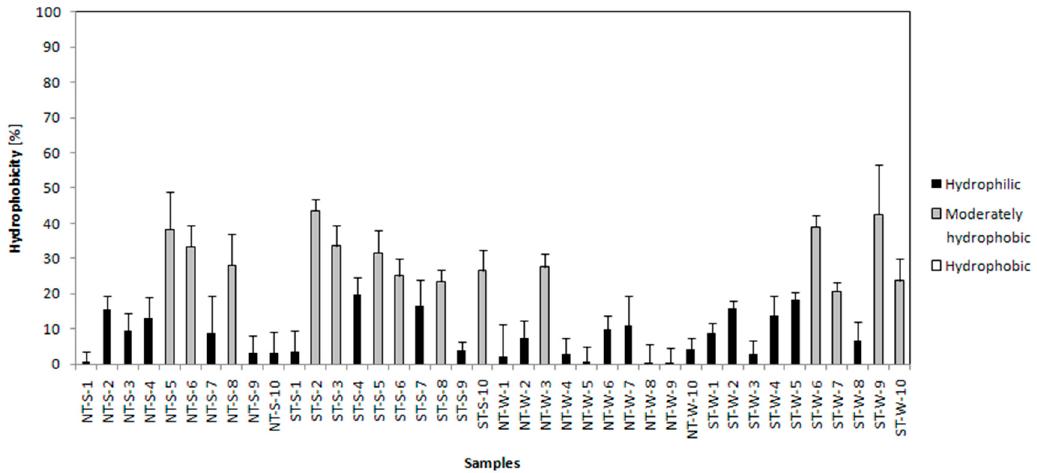
Figure 4. Hydrophobicity (%) of tetracycline-resistant isolates from the wastewater treatment plant measured at 620 nm. Samples defined the degree of hydrophobicity as hydrophilic (<20%), moderately hydrophobic (20%–50%), and hydrophobic (>50%).